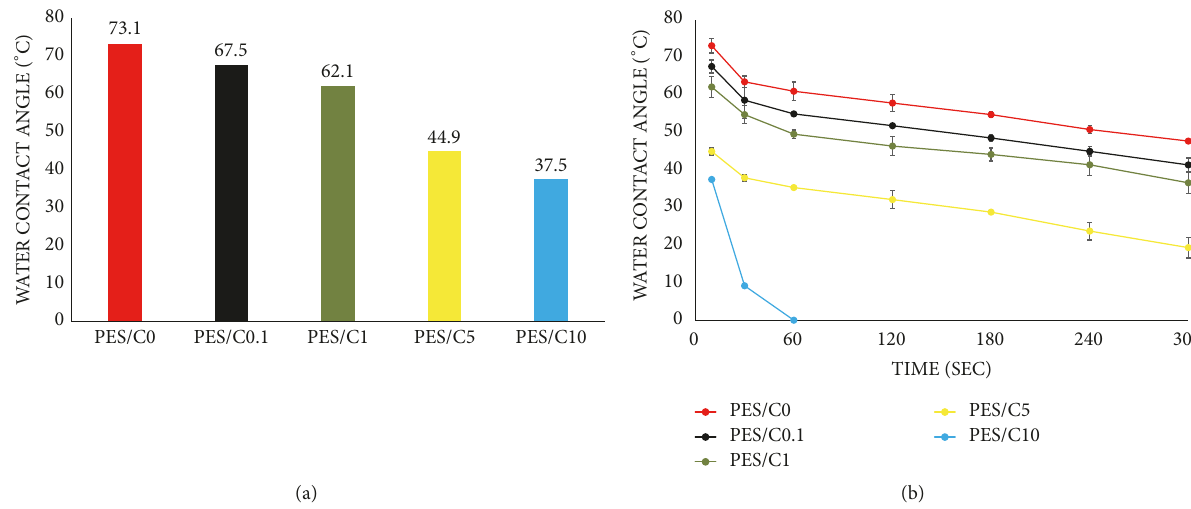
Figure 12: The static water contact angle (a) and the time-depended values (b) for a sessile drop spreading over a range of PES membranes produced with Cyrene (cid:2) .